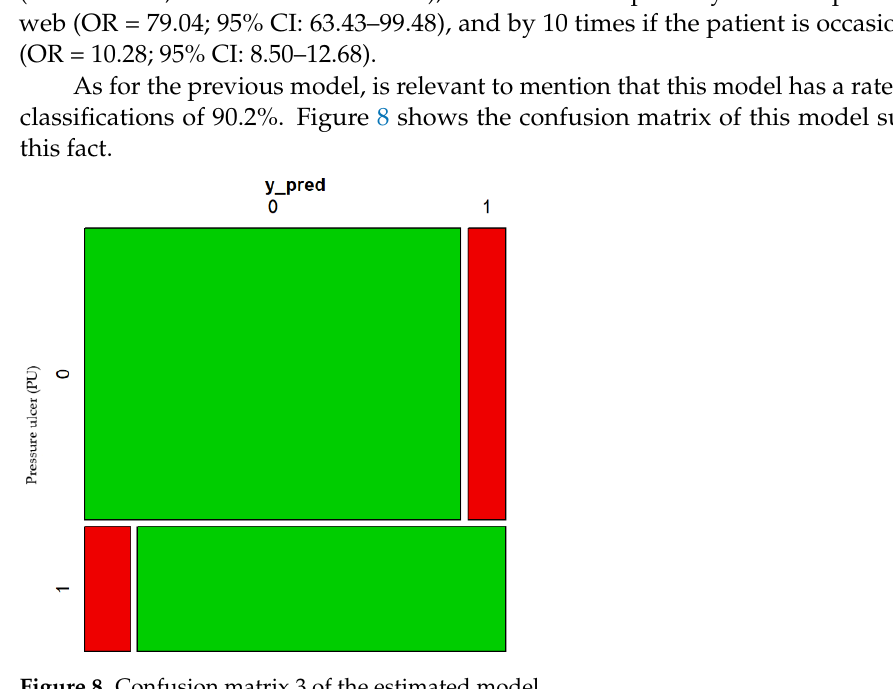
Figure 8. Confusion matrix 3 of the estimated model.